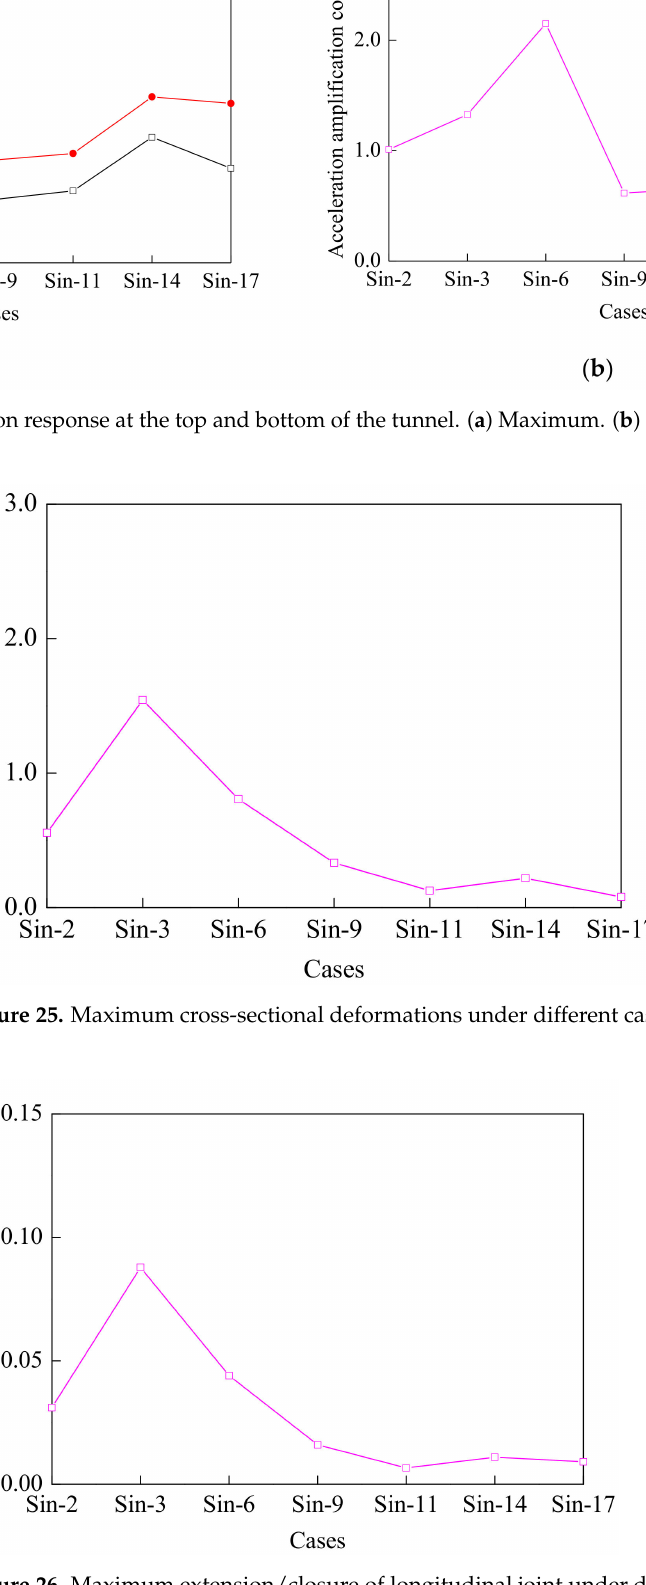
Figure 26. Maximum extension/closure of longitudinal joint under different